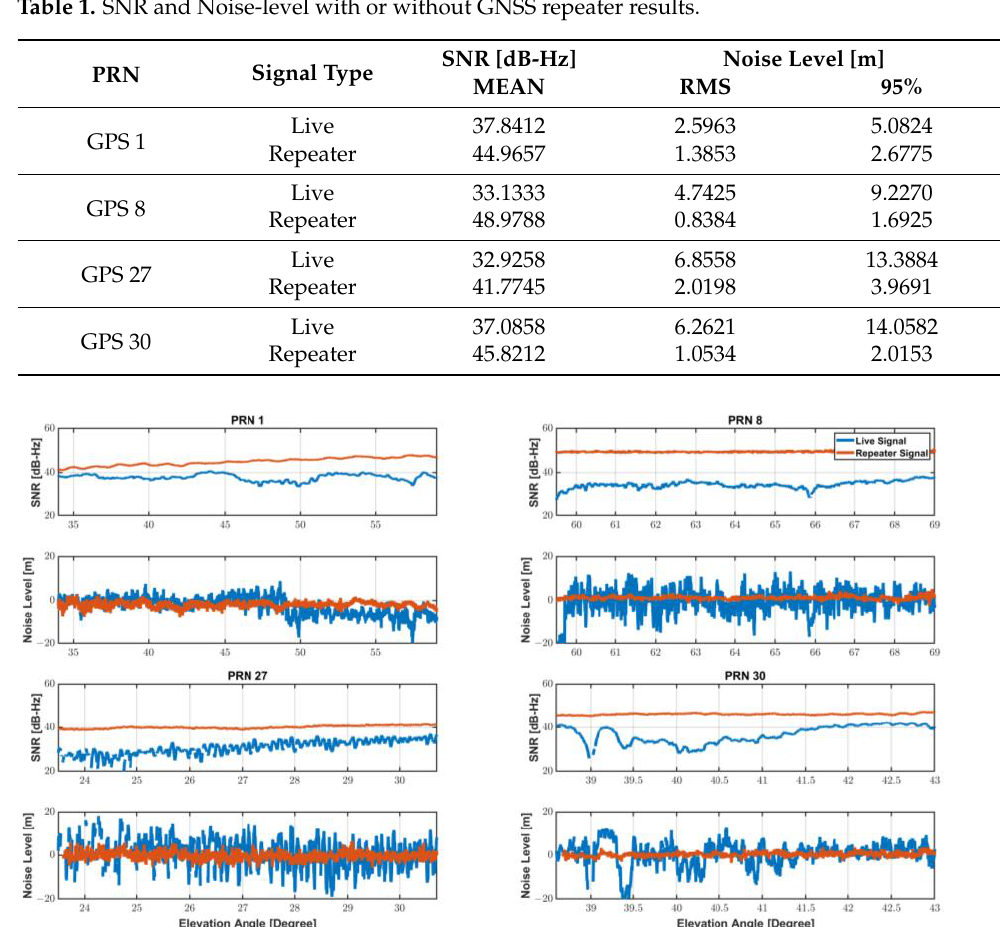
Table 1. SNR and Noise-level with or without GNSS repeater results.